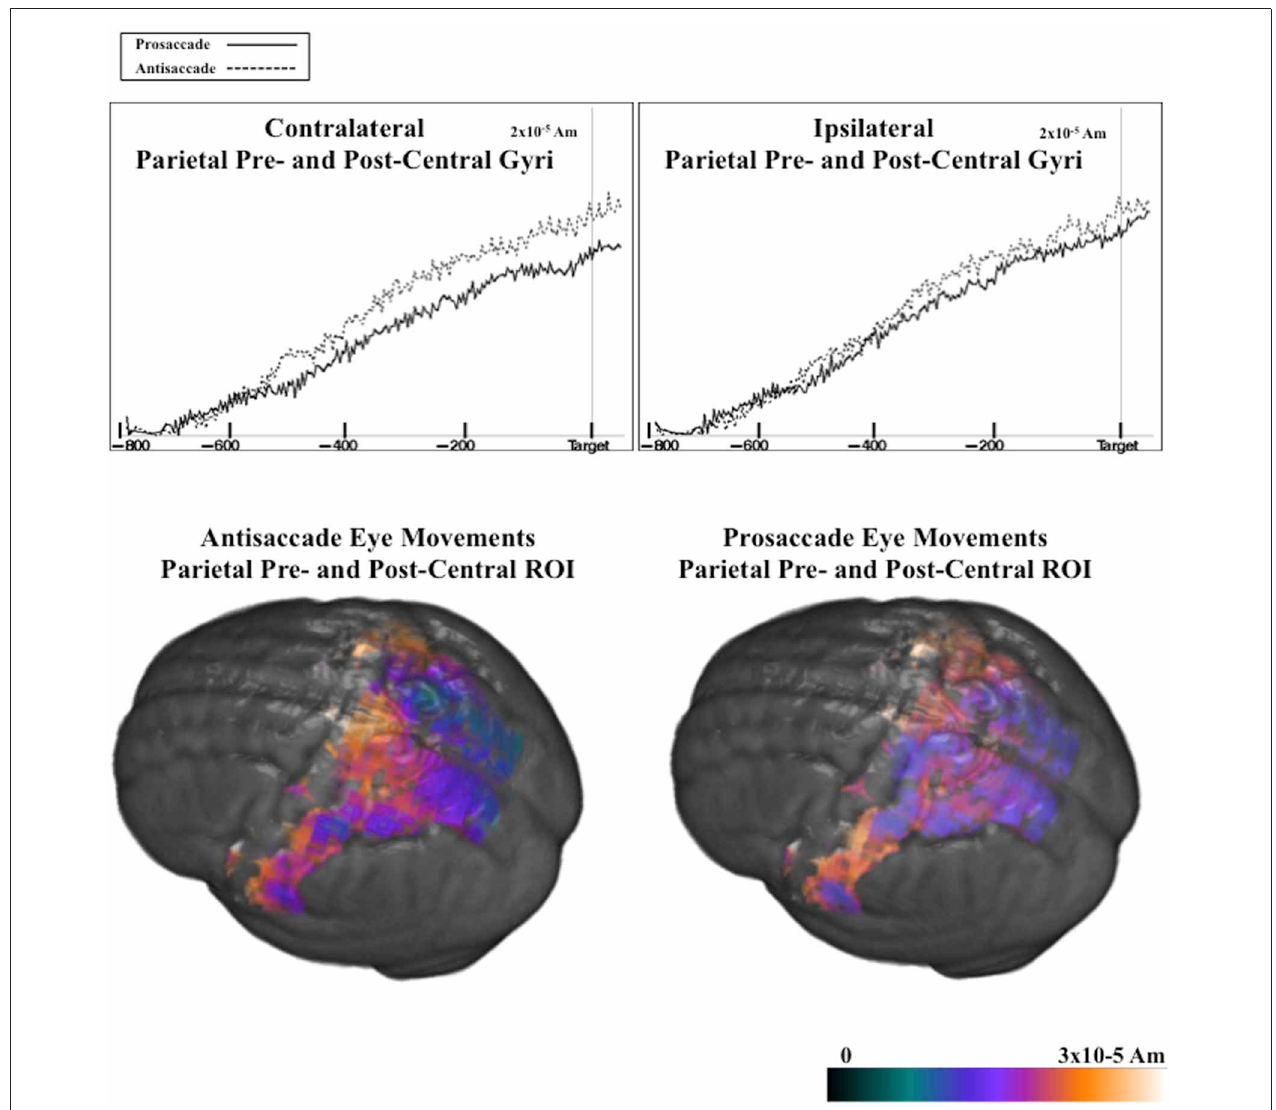
FIGURE 9 | (Top panel) Temporal unfolding of the current density sources for the parietal, pre- and post-central gyri ROIs as a function of the eye movement type and side of the eye movement, for the